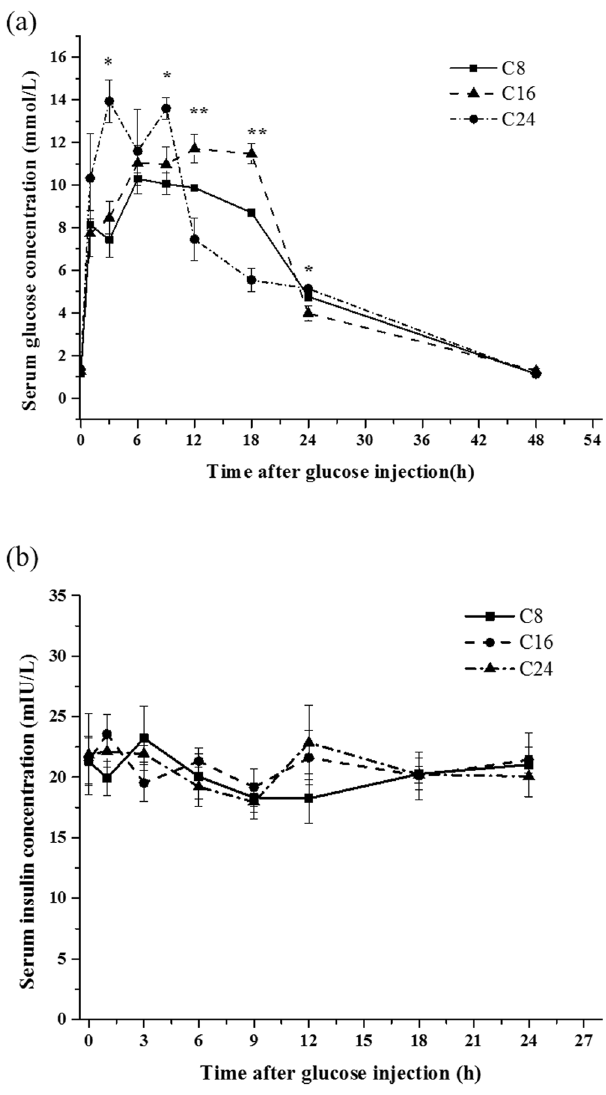
Figure 2. Response to glucose tolerance test of Japanese flounder after the 10-week feeding trial. ( a ) Serum glucose concentrations (b ) Serum insulin concentrations. Values at 0 h are presented as mean ± S.D., n = 3 (8 fish/replicate) and the other values represented the means ± S.D., n = 3 (3 fish/replicate). * represents significant difference between C24 and C8 ( P < 0.05); ** represents significant difference among all groups, ( P < 0.05).